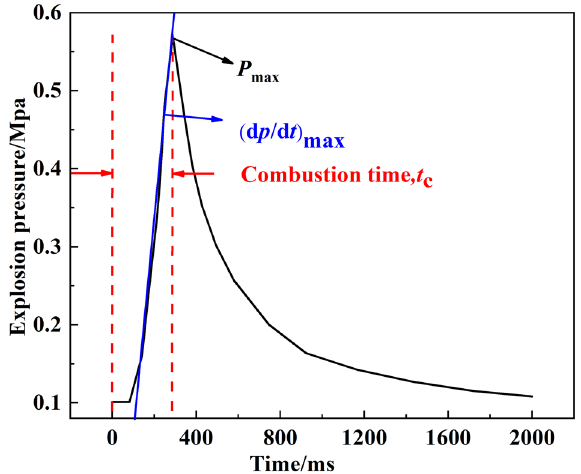
Figure 2. Typical pressure trajectory during an explosion.